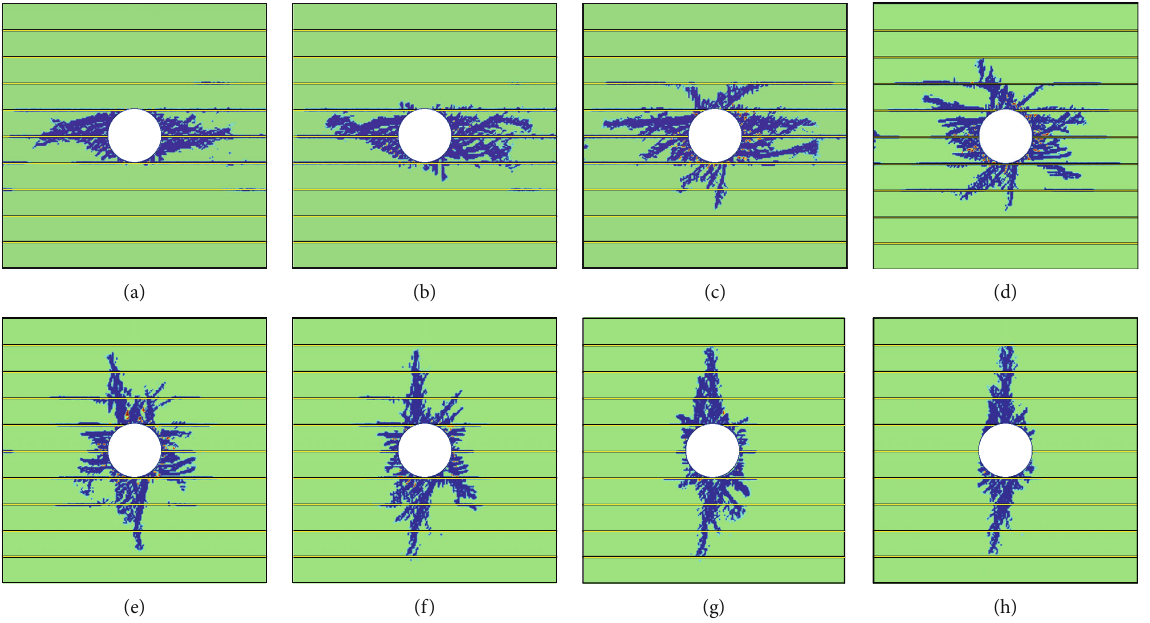
= 5MPa , σ = 1 MPa x y = 3MPa , σ = 5 MPa ; x y